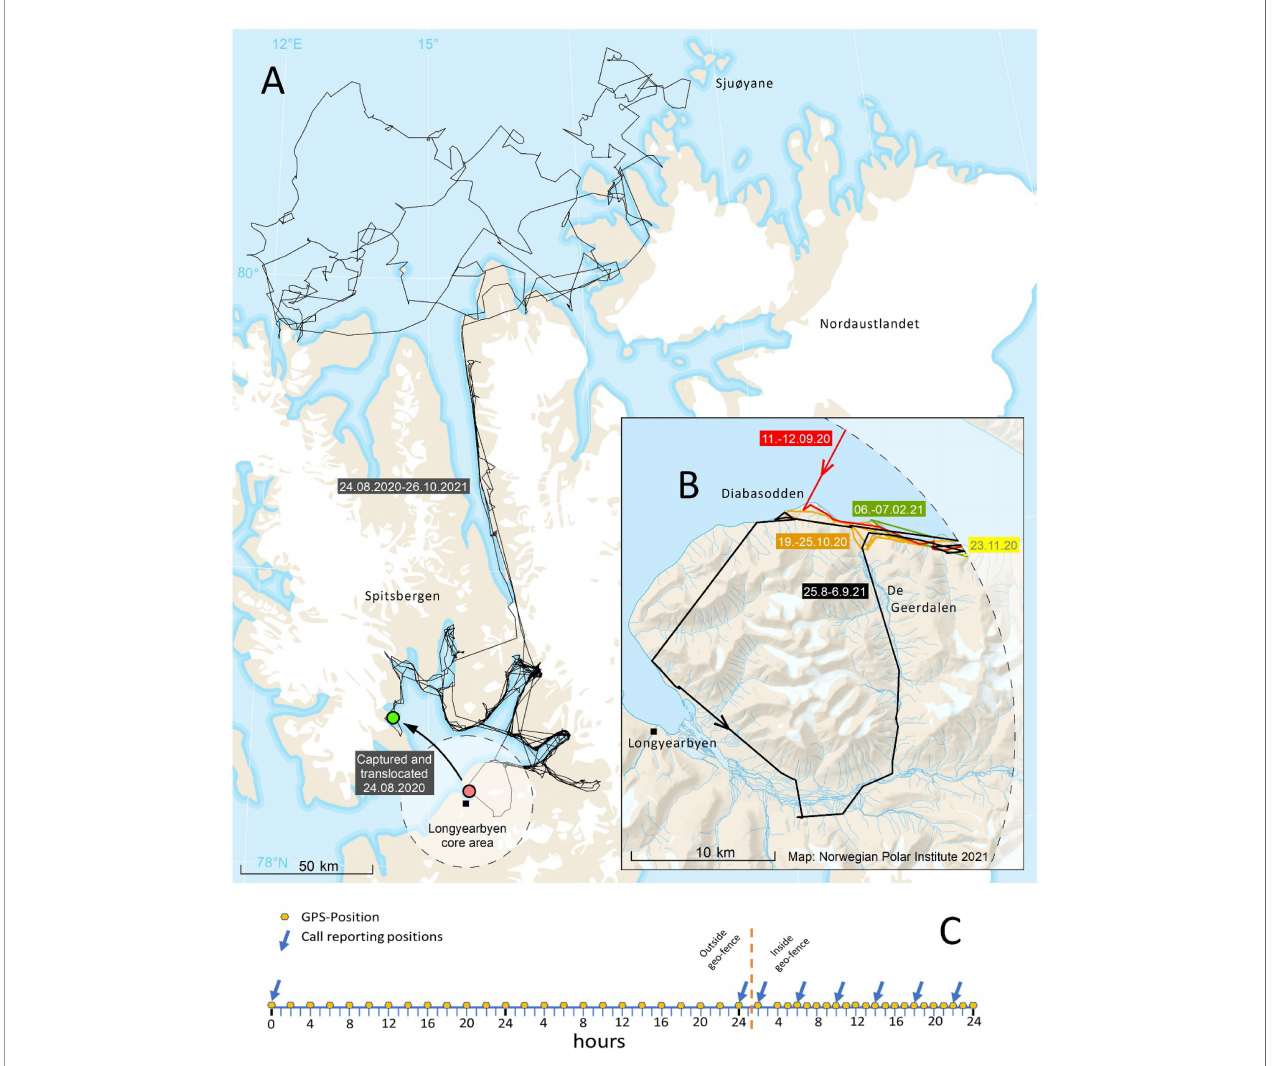
FIGURE 11 | Movements of an adult female polar bear near Longyearbyen, the main settlement in Svalbard, in August 2021 (A, B) . The Telonics iridium collar was set to collect GPS positions every other hour and report them every second day. When the collared bear moved inside a circle with radius of 25 km ( ‘ geo-fence ’ ) from Longyearbyen, the collar sent data more frequently (collecting a GPS location every hour and reporting every 4 th hour) so the bear ’ s proximity to town could be monitored (C)